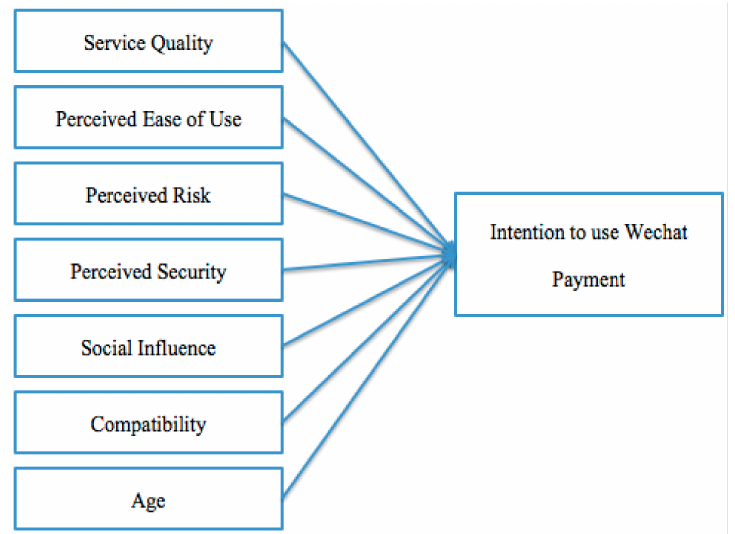
Figure 1. The proposed research